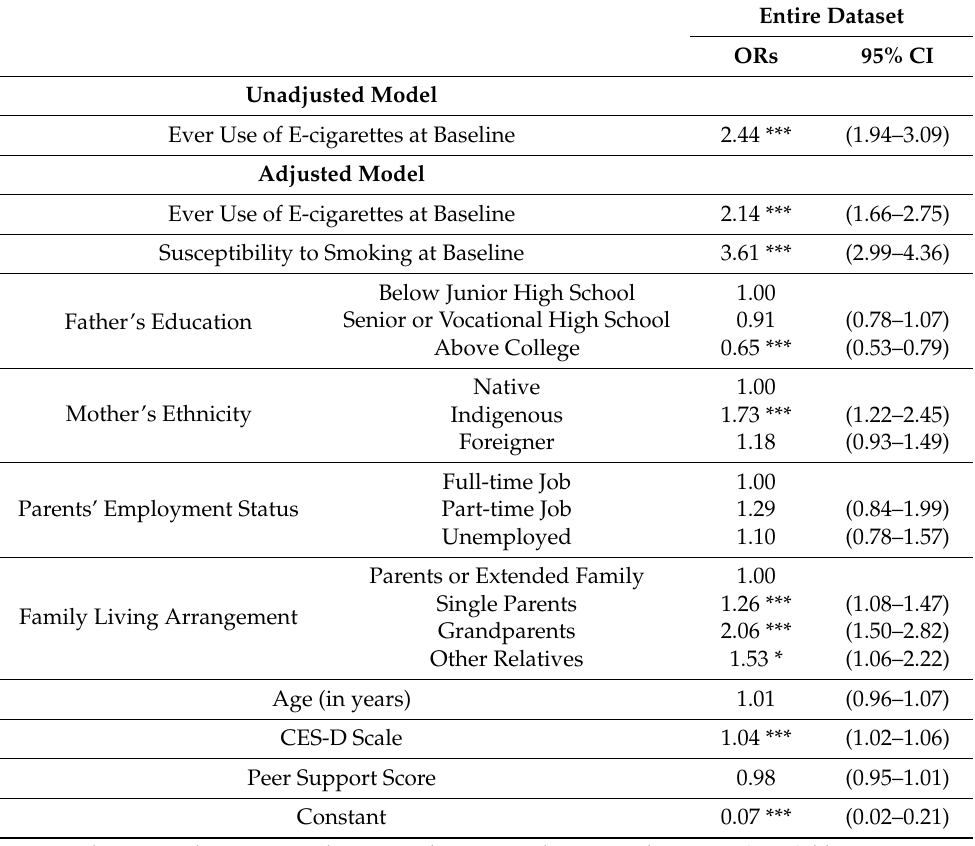
Table 2. Logistic regression output for smoking initiation—weighted estimates (observations: